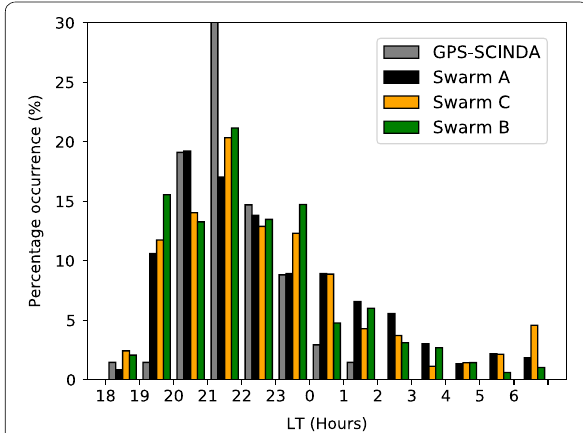
Fig. 6 Percentage occurrence of ionospheric irregularities observed by Swarm and amplitude scintillation recorded by GPS-SCINDA as a function of local time for the years from 2014 to